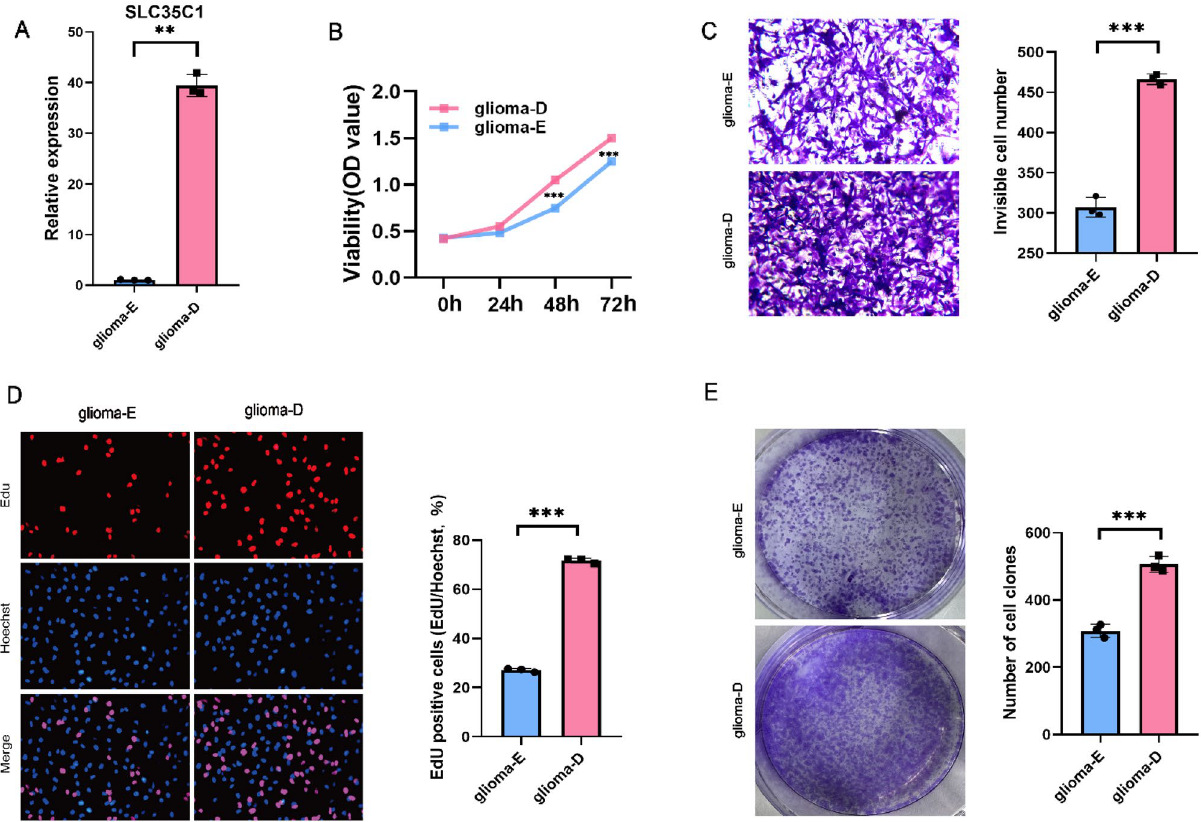
Figure 13. Overexpression of SLC35C1 promotes proliferation, migration, invasion and colony formation of glioma cells in vitro. ( A ) PKlv2-SLC35C1 plasmid (glioma-D) and Empty vector (glioma-E) were stably transfected into glioma cells, respectively, and the expression of SLC35C1 was detected by qRT-PCR. ( B ) Cell proliferation was detected by using the CCK8 proliferation reagent. ( C ) Invasiveness of glioma cells analyzed by transwell invasion assay (magnification, × 100) and bar graph showing quantitative results of the transwell assay. ( D ) The picture shows the PKlv2-SLC35C1 plasmid (glioma-D) group and the empty vector (glioma-E) group EdU-labeled cells, Hoechst-stained cells, and Edu merged with Hoechst; Bar graphs analyzed the rate of Edu- positive cells in the two groups. ( E ) Plate clone formation assay detects cell proliferation capacity and colony formation. *P < 0.05; **P < 0.01; ***P <